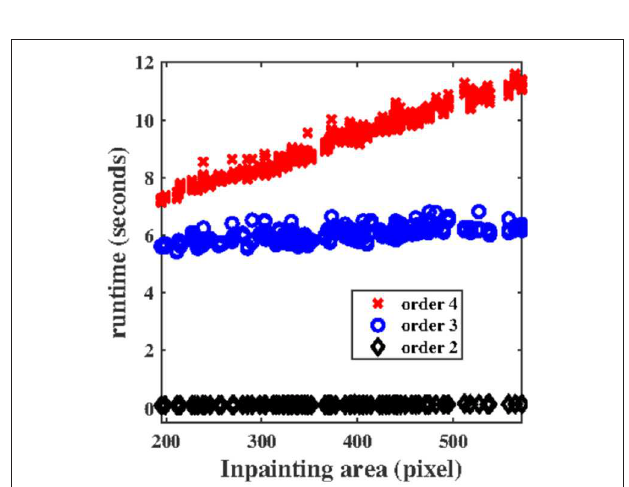
FIGURE 6 | Obtained PSNR values for different spline orders and standard TV. Left: random inpainting area; right: scratches; top: cartoon-like images; bottom: natural images.